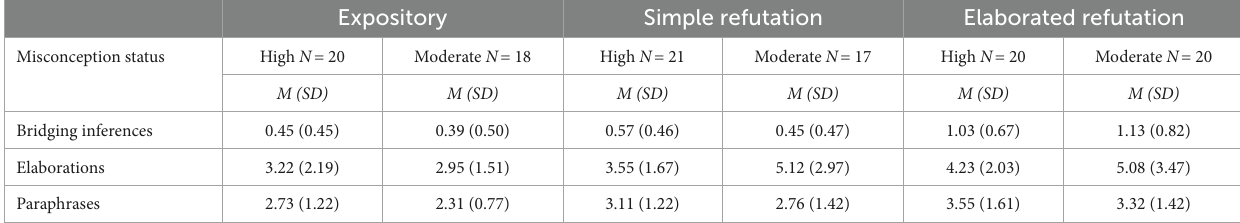
TABLE 1 Means and standard deviations of online processing strategies by text type and misconception status for targeted text segments.